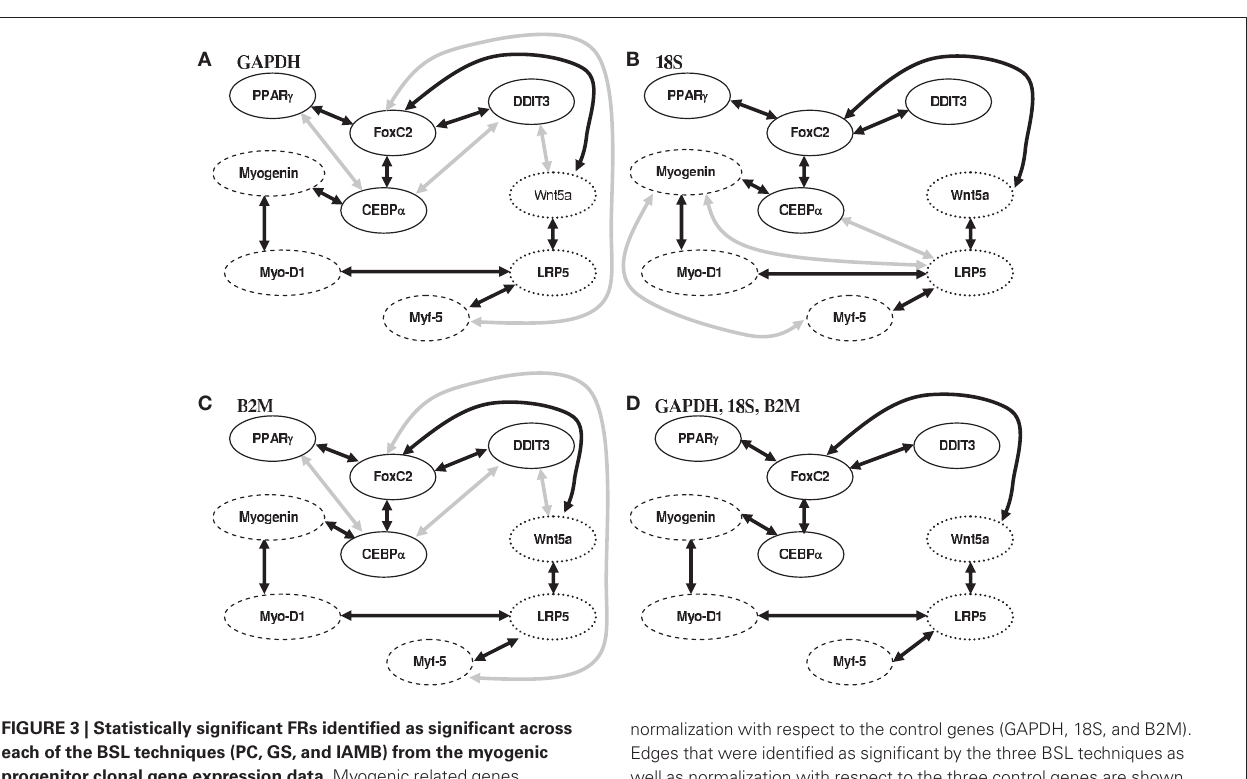
normalization with respect to the control genes (GAPDH, 18S, and B2M). Edges that were identified as significant by the three BSL techniques as well as normalization with respect to the three control genes are shown in (D) . These edges are also represented by dark arrows in the subplots (A–C)